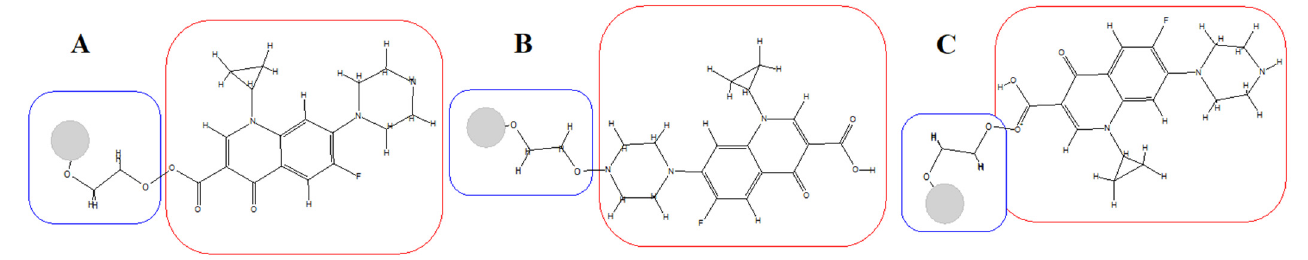
Figure 2. Chemical structure models of the AgNP-PEG-CIP (two methylene units,-CH 2 -CH 2 , of the AgNP-PEG, i.e., AgNP-O-(CH 2 -CH 2 )n-O-CIP interactions, showing OH, NH, and C=O sites); blue and red encased area represent PEG and CIP, respectively; the circle represents the AgNPs; ( A ) represents –(C=O)-OH-based CIP conjugation, ( B ) represents piperazinyl NH-based CIP conjugation, and ( C ) represents (HO-)-C=O-based CIP conjugation.